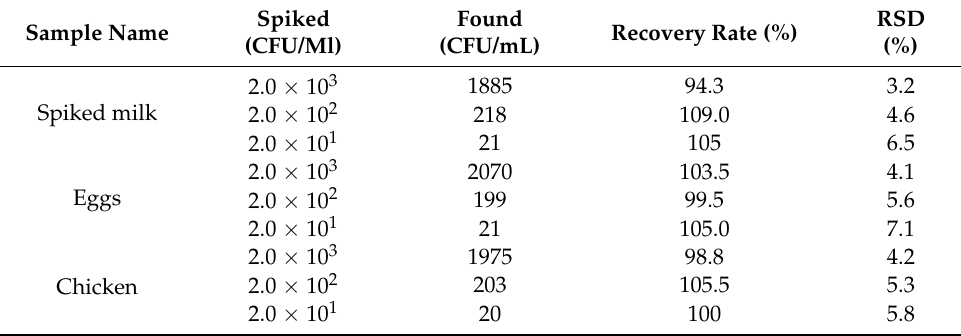
Table 1. Measurement results of actual